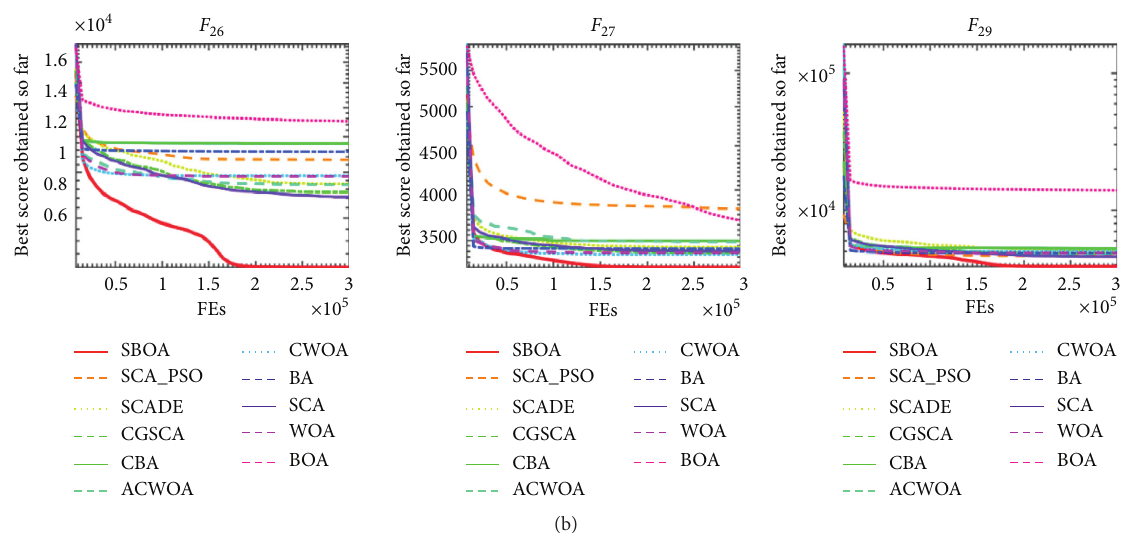
Figure 3: Convergence curves of 9 selected benchmark